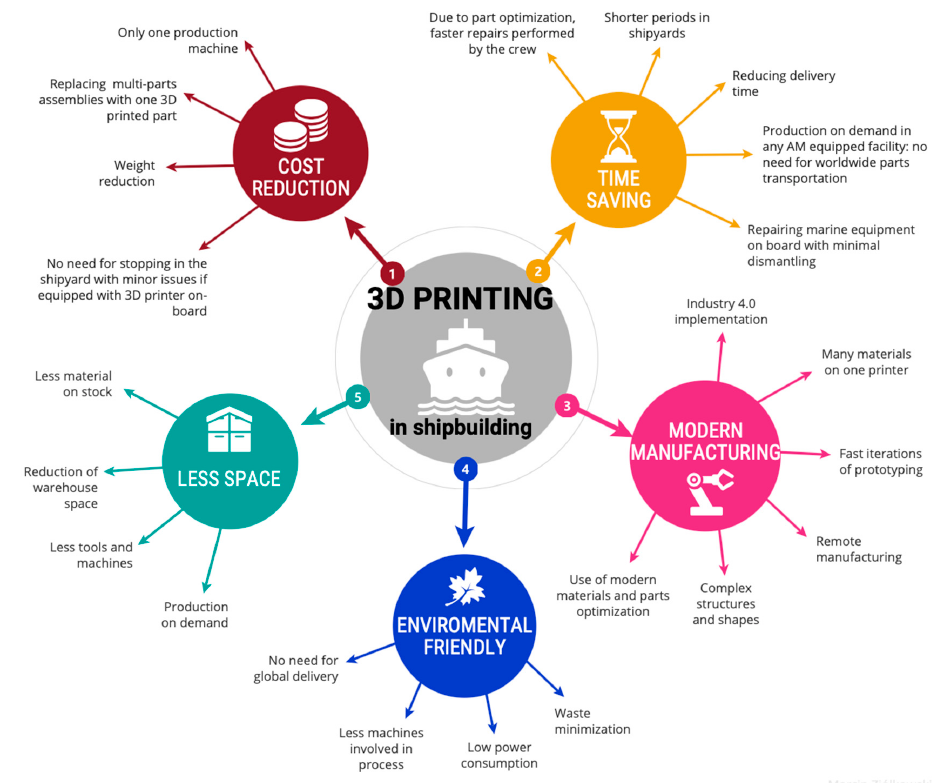
Figure 20. Graphic representation of the benefits of using 3D printing in shipbuilding.